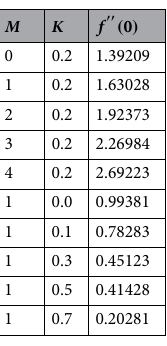
Table 2. Numerical computation for drag force − f ′′ ( 0 ) with various values of M and K with n = 2, (cid:31) = 0.5, R = 0.2, Ec = 0.1, and Pr = 10.